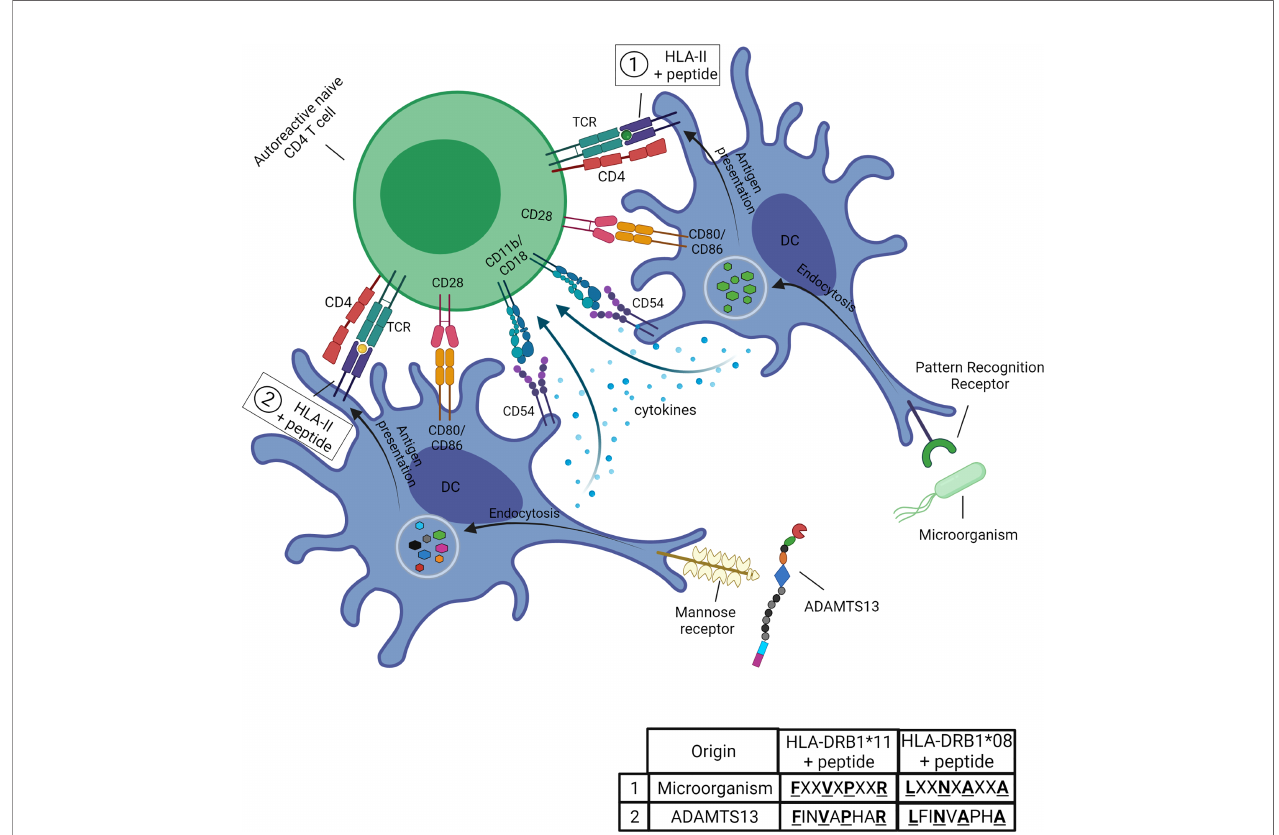
FIGURE 4 | Potential role of molecular mimicry in iTTP. The microorganism is recognized by pattern recognition receptors (PRR) on APC (in this fi gure, dendritic cells, DC) followed by the uptake via the process of endocytosis. After antigen processing the microorganism-derived peptides (peptides 1 in table) are loaded onto the HLA-class II molecule (the risk allele HLA-DRB1*11 or HLA-DRB1*08:01, respectively) and presented to the TCR of an autoreactive CD4 T cell. The CD4 T cell cross-reacts with ADAMTS13-derived peptides (peptides 2 in table) presented in the HLA-II molecule (HLA-DRB1*11 or HLA-DRB1*08:01, respectively). The ADAMTS13-derived peptides show similarities with the microorganism-derived peptides for certain aminoacid positions (for example the anchor residues as indicated by the bold and underlined letters). The co-stimulatory and adhesion molecules (CD80/CD86 and CD54, respectively) on the APC are required for the activation of the autoreactive CD4 T cells. The ADAMTS13-derived peptides are obtained by the uptake of ADAMTS13 using the mannose receptor on APC. The cytokines produced by the APC are required for the differentiation of the naïve CD4 T cell into an effector CD4 T-cell population. Figure created with